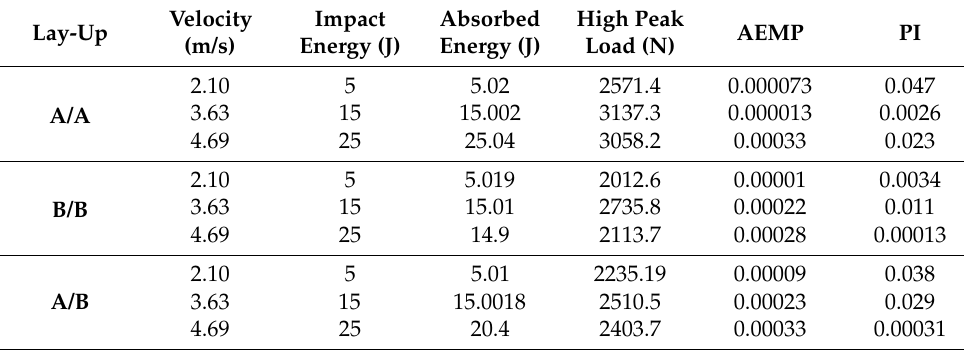
Table 4. Summary of the results of non-dimensional